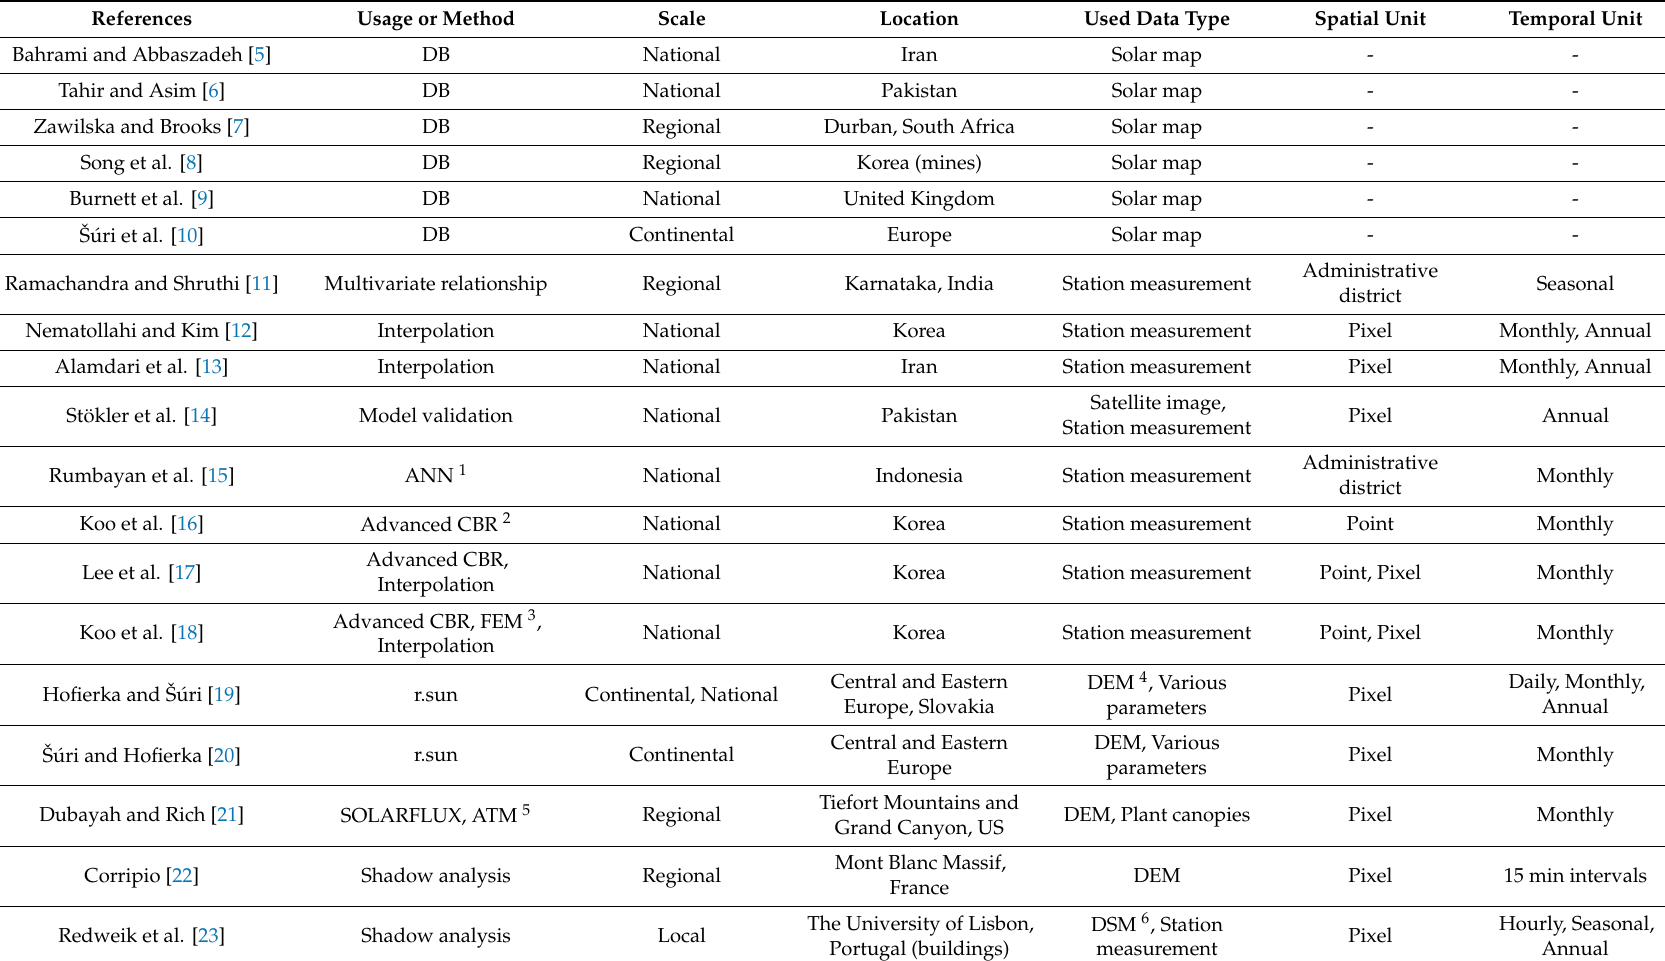
Table 1. Summary of previous solar radiation mapping studies using